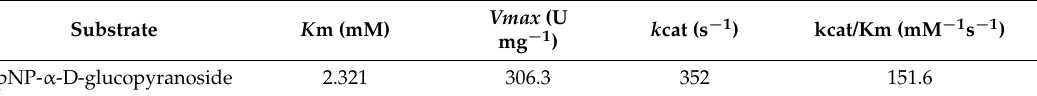
Table 3. Substrate specificity of recombinant GSJ on p NP derivatives.